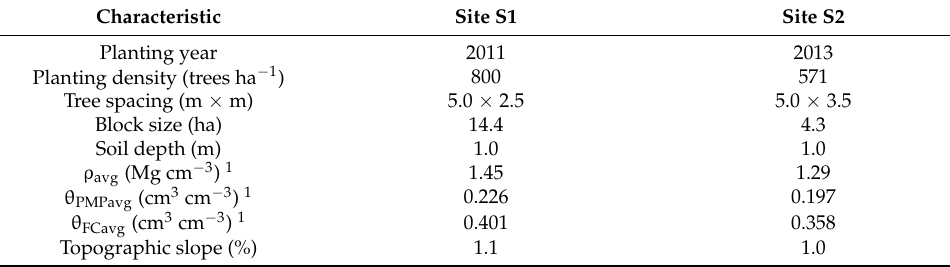
Table 1. Site characteristics and soil water properties at the study